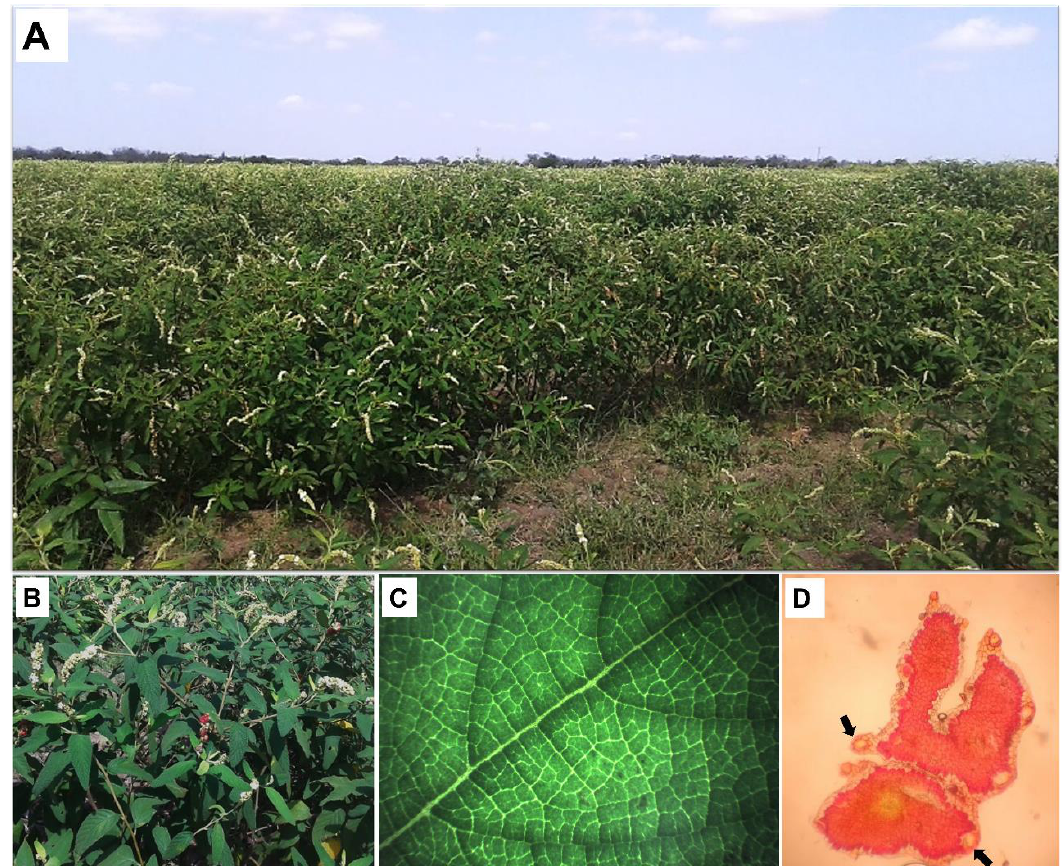
Figure 1. Images of V. curassavica . ( A ) at the place of cultivation. ( B ) The leaves, flowers and fruit of the plant. ( C ) The leaf details. ( D ) A leaf under microscopy showing the epidermis and the essential oil storage location (black arrows).